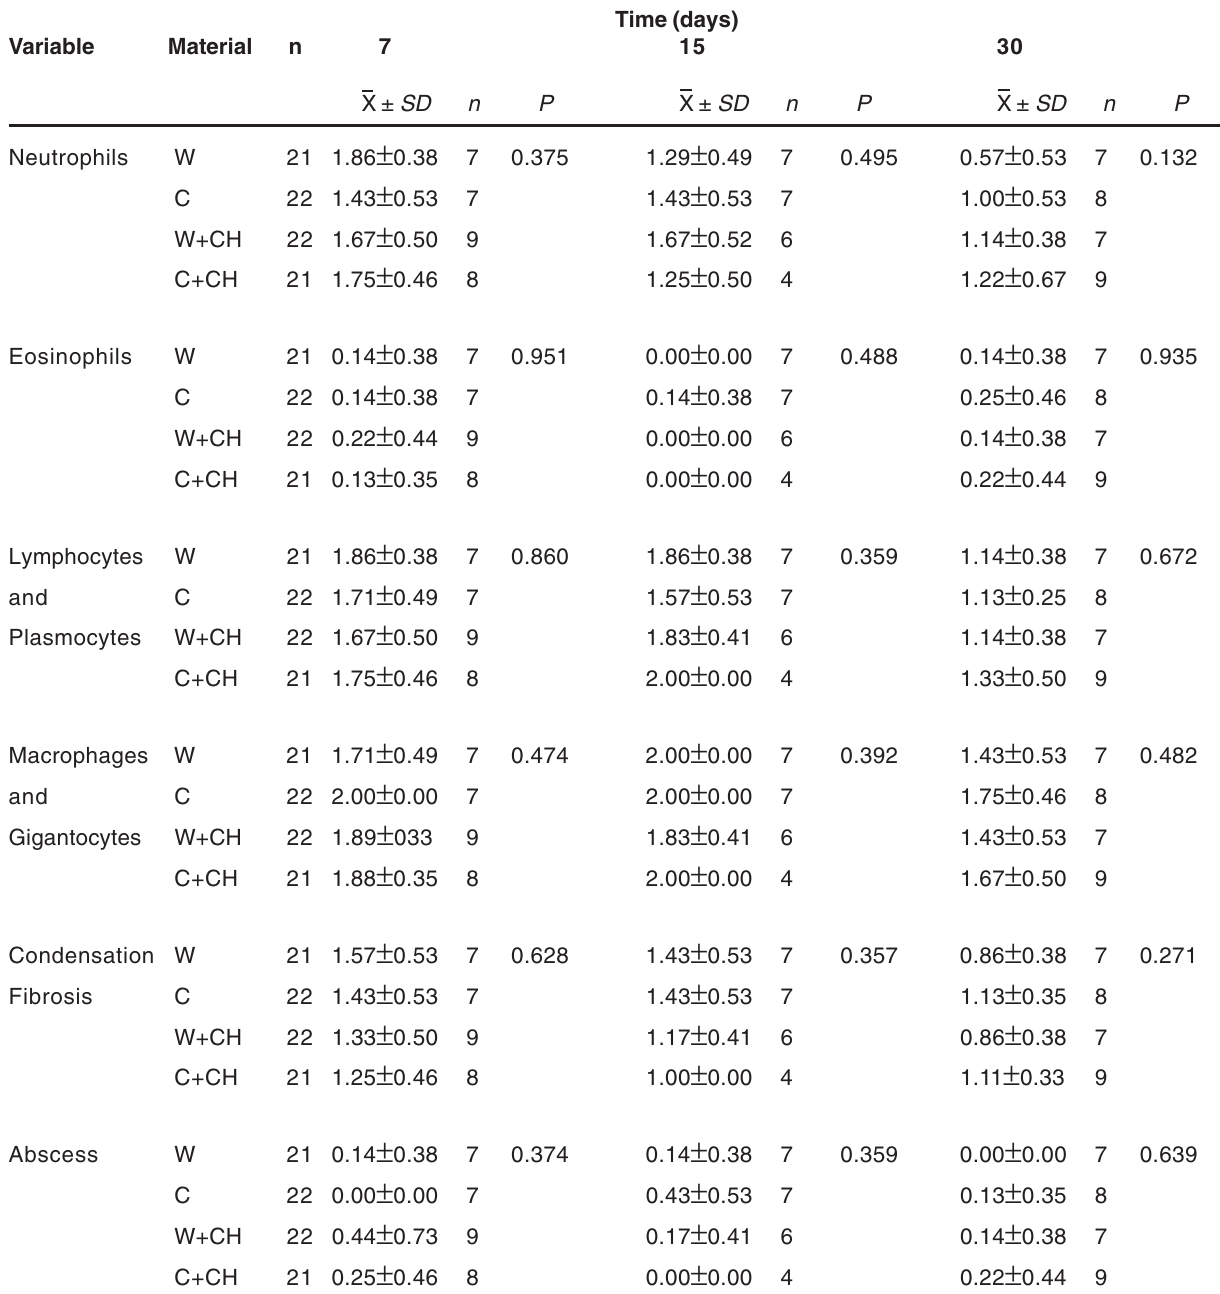
TABLE 1- Aspects related to the inflammation between the tested materials and time intervals (data presented as mean±standard deviation (X±SD); significance level 5% (p<0.05); W – Distilled Water; C – Chlorhexidine; W+CH – Distilled Water associated with Calcium Hydroxide; C+CH – Chlorhexidine associated with Calcium